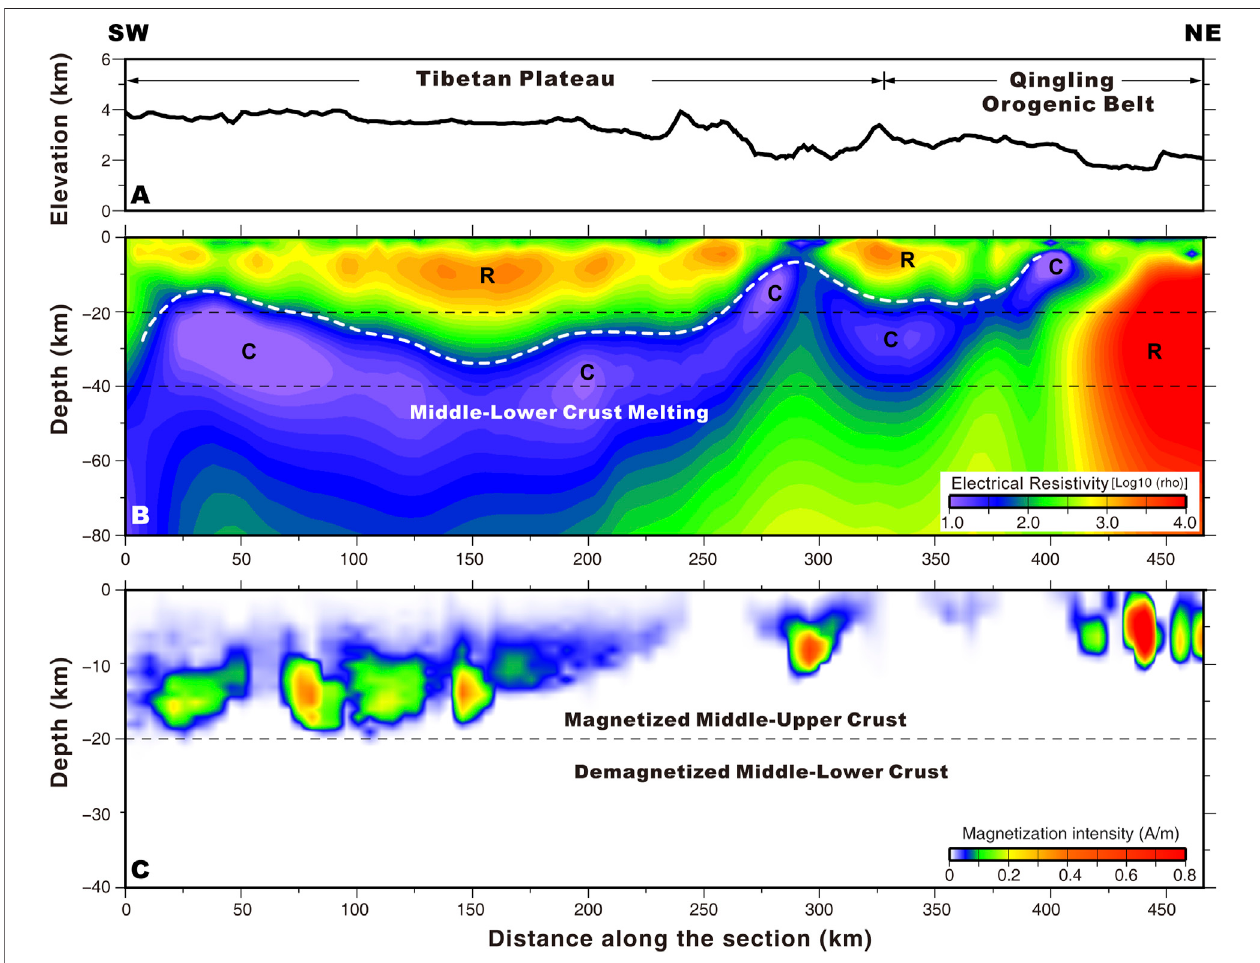
FIGURE 9 | Line four magnetotelluric survey magnetization distribution pro fi le: (A) altitude (B) electrical resistivity and (C) magnetization distribution.